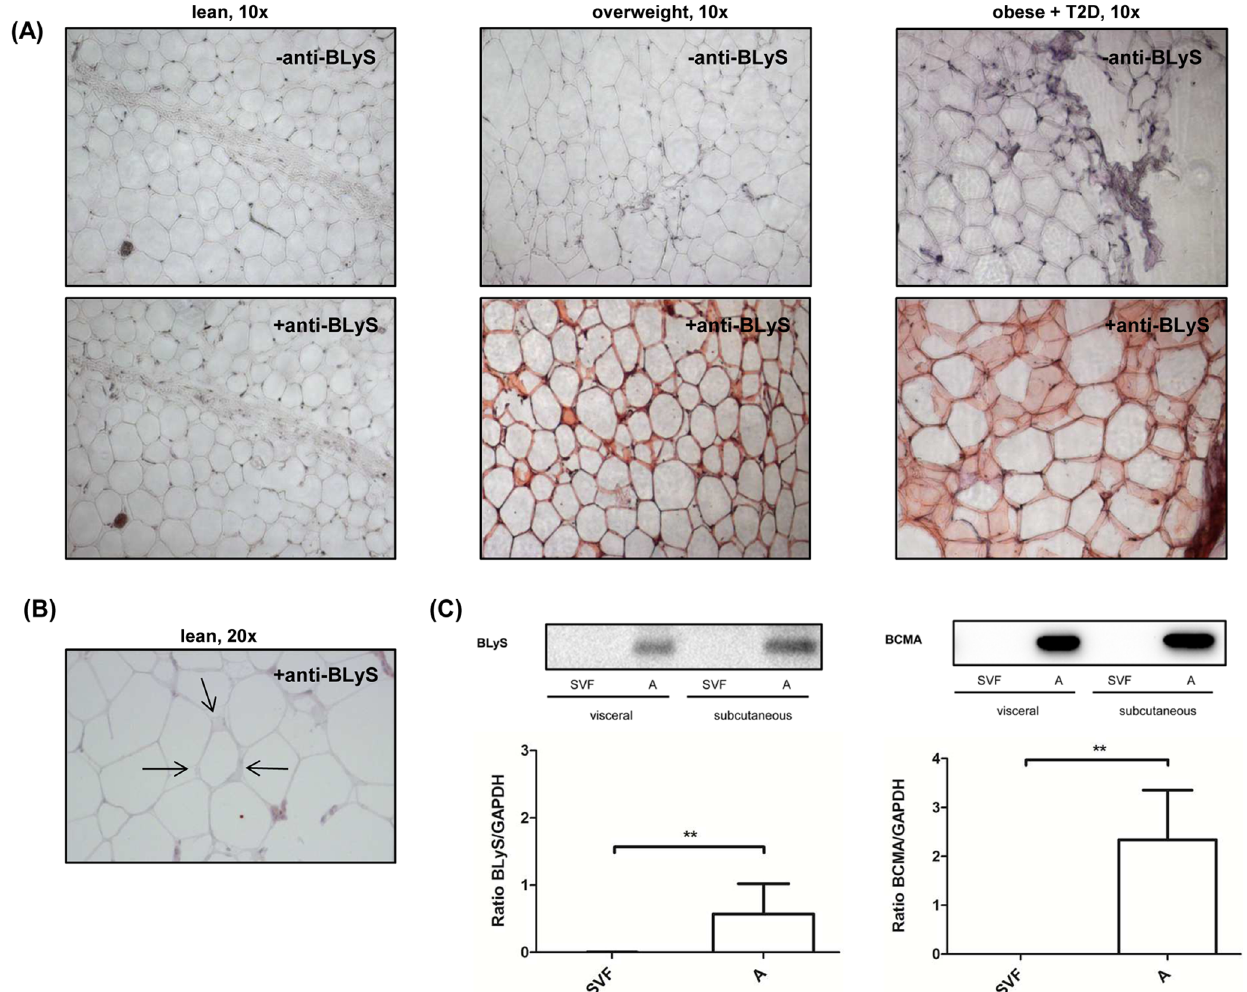
Figure 1. BLyS expression in adipose tissue in humans invivo . (A) BLyS immunohistochemistry (lower panel) and haematoxylin staining (upper panel) of subcutaneous adipose tissue biopsies of lean (left), overweight (middle) and obese + type 2 diabetes (T2D) (right) human subjects (10 6 ). The reddish color represents BLyS-positive mature adipocytes. (B) shows 20 6 magnification of the immunohistochemistry of a lean adipose tissue biopsy in which the arrows demonstrate the stromal vascular fraction. The lean representative was chosen as BLyS expression was rarely detectable in their adipocytes, thus resulting in a more reliable visual interpretation of the stromal vascular fraction. (C) BLyS and BCMA protein detection revealed that BLyS and BCMA is only expressed in the mature adipocyte [A] fraction but not in the stromal vascular fraction [SVF]. Densitometry graphs data in this figure are shown as means + SEM (n=5).